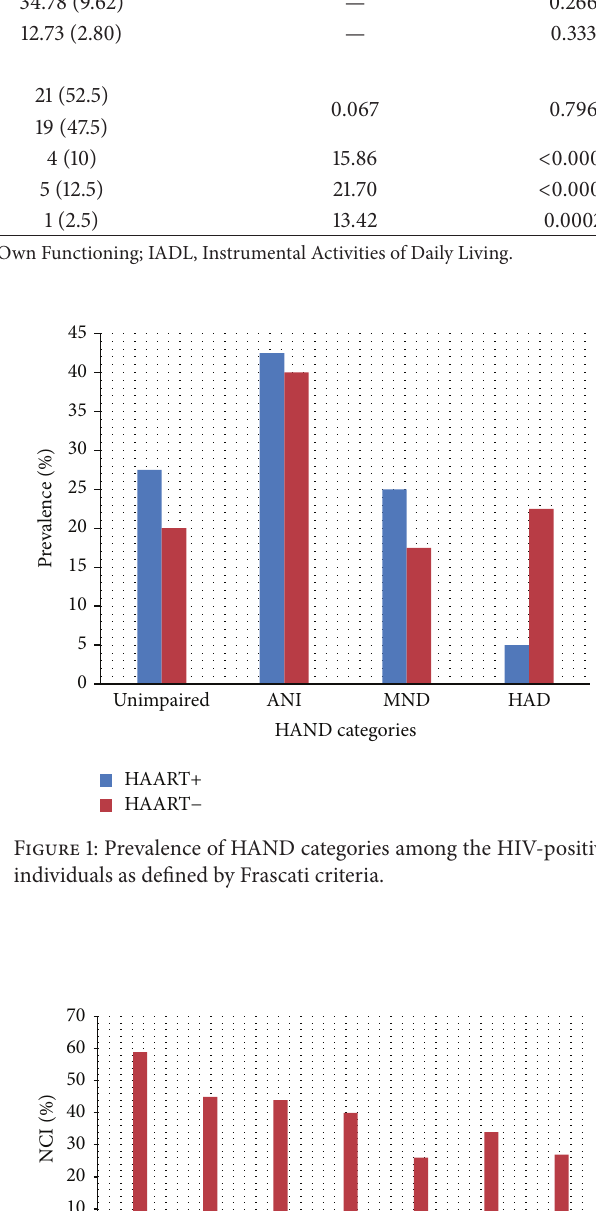
symptomatic HAND, fewer years of education independently predicted symptomatic HAND (see Table